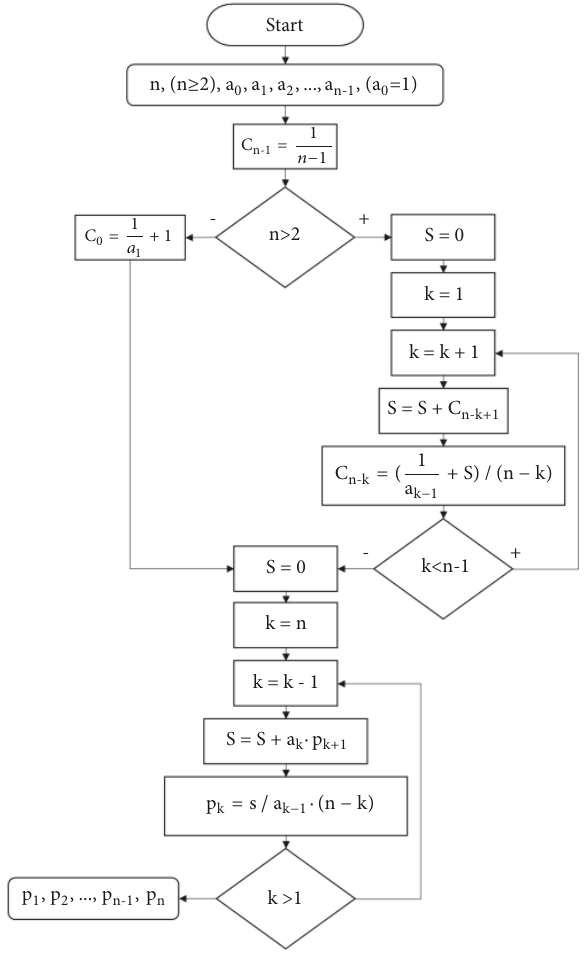
Figure 2: Flowchart of the